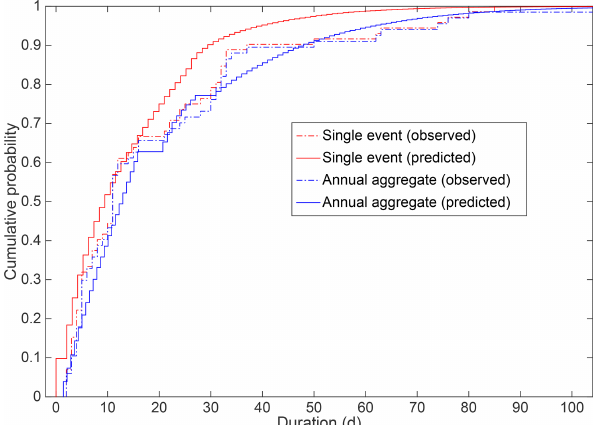
Figure 4. Empirical cumulative density functions for historical and model-predicted snow disaster duration.